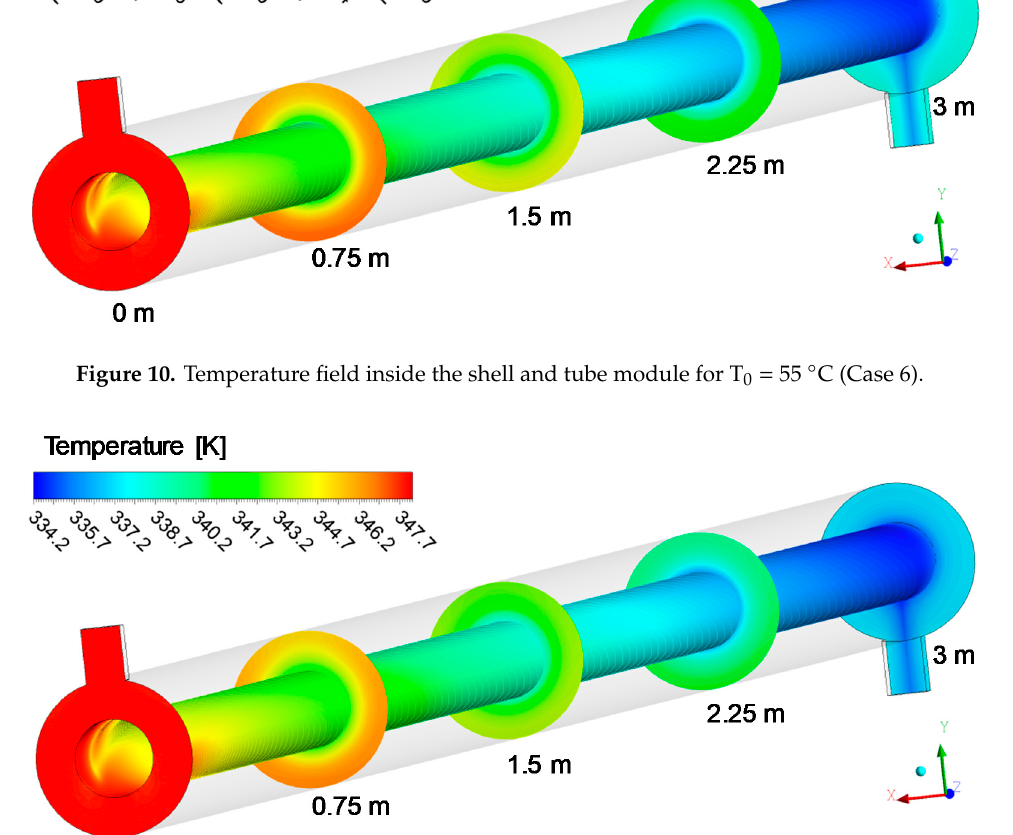
Figure 11. Temperature field inside the shell and tube module for T 0 = 75 °C (Case 7).